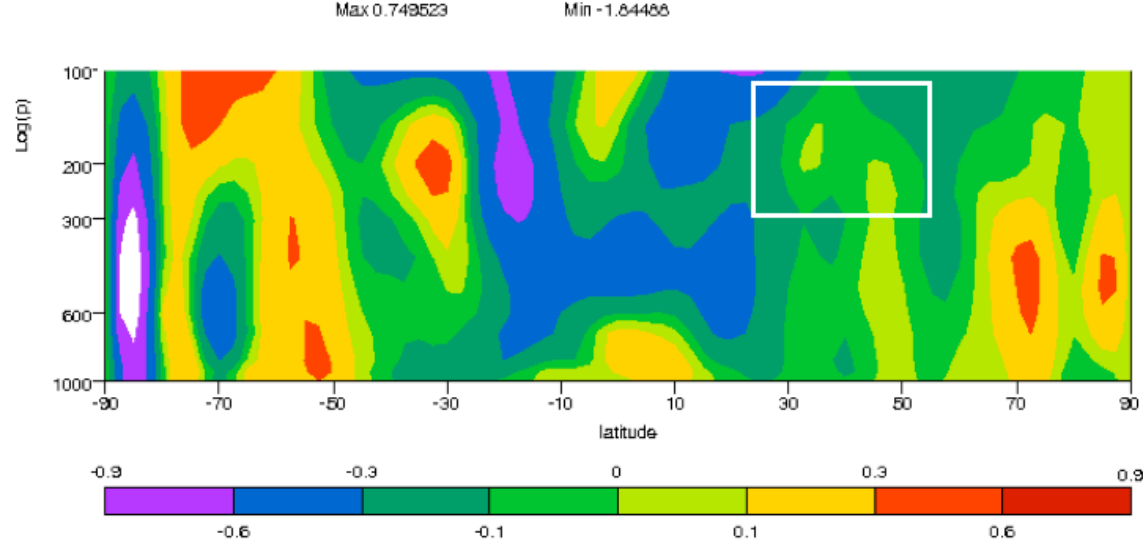
Figure 6. The difference in acceleration measured at 300 and 500 hPa for individual radiosonde stations. Median (circle) and error bars are derived from the data points within each 5° latitude band (see text.) 99UTC is the average of 00 and